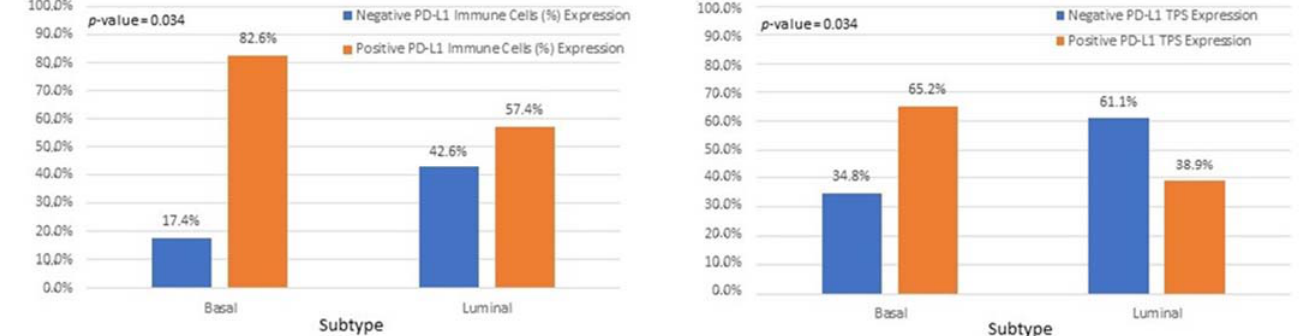
Figure 7. ( A , B ) Strong positive PD ‐ L1 membranous expression in tumor cells of a basal type MIBC (×200, ×400); ( C ) Strong positive membranous expression of PD ‐ L1 in immune cells present in the contiguous peritumoral stroma of pTa NMIBC (×200 ) .